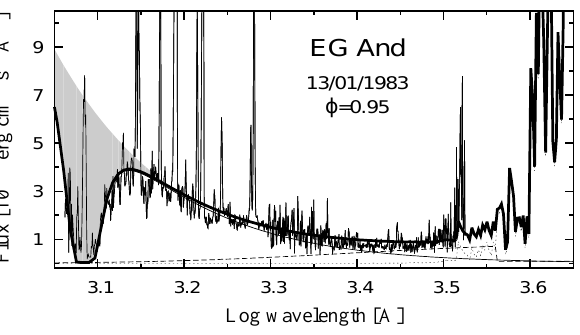
Figure 5: Strong attenuation of the far-UV continuum by Rayleigh scattering process (gray area) in the spec- trum of EG And, close to the inferior conjunction of the